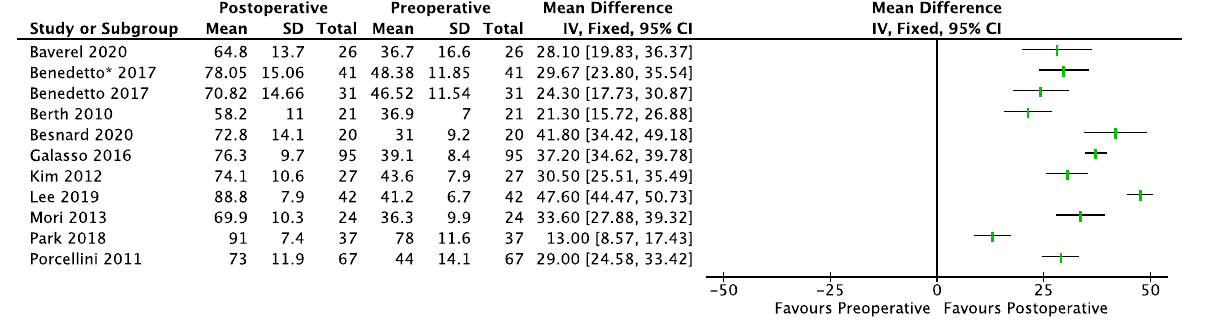
Figure 2. Forest plot of comparison: CMS (Constant-Murley Score), outcome in PCR-BT. SD: Standard Deviation. Di Benedetto * follow-up of 6.5 years; Di Benedetto follow-up of 3 years.